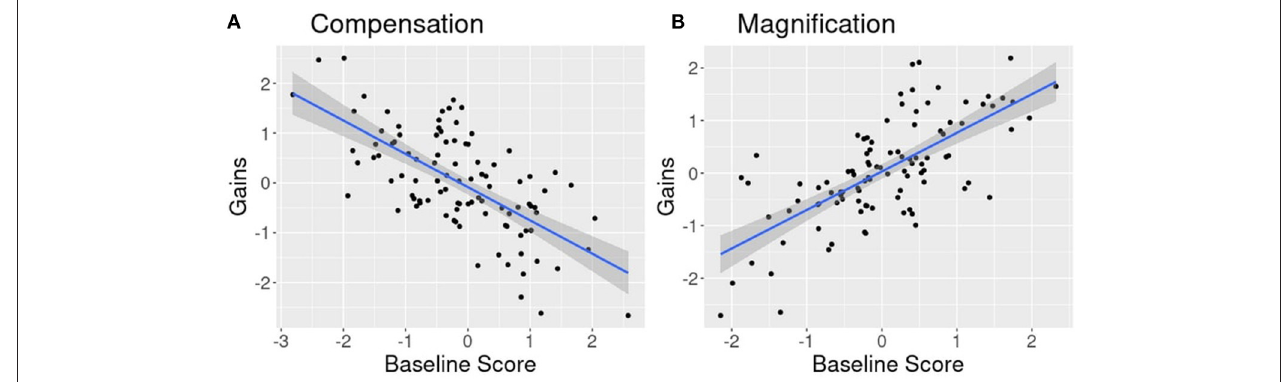
FIGURE 1 | Example of opposing patterns of the relationship between baseline cognitive ability and gains after cognitive training. (A) Compensation effect demonstrating lower performing individuals accruing the most gains after training. (B) Magnification effect demonstrating higher performing individuals accruing the most gains after